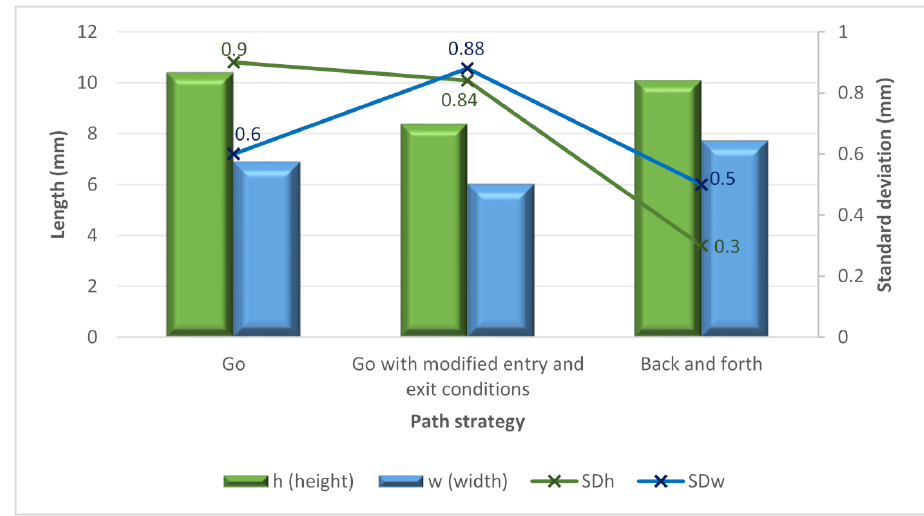
Figure 9. Average height, width and average standard deviations (on samples A, B and C) versus the path strategy.